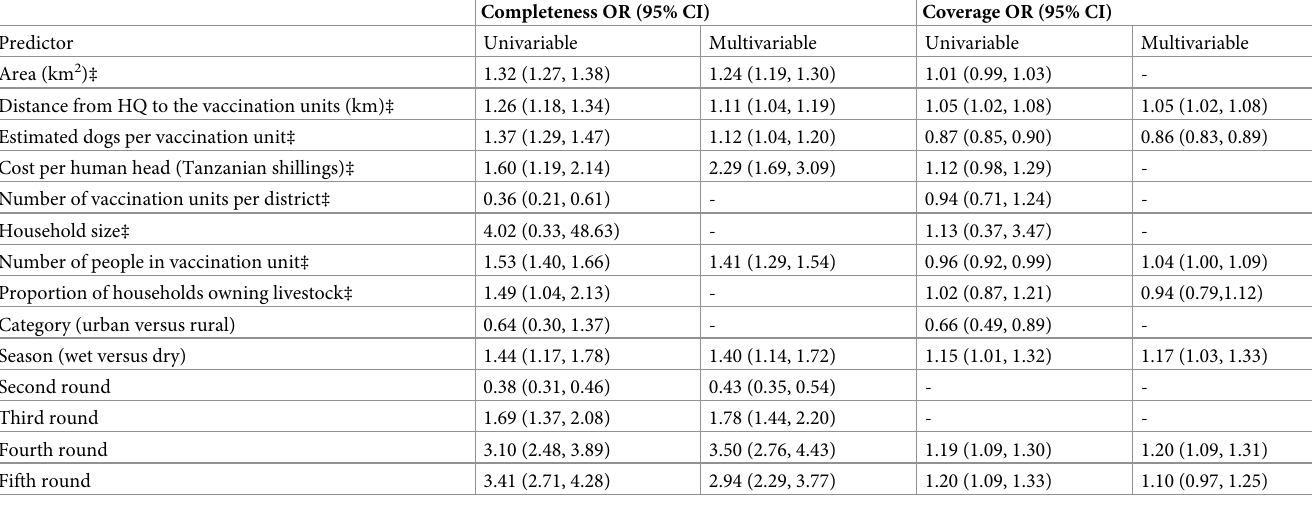
Table 4. Odds ratio (OR) estimates of characteristics of vaccination units (predictors) and the success of rabies vaccination campaigns in terms of coverage and completeness. OR and 95% confidence intervals (CIs) were estimated using binomial generalised linear mixed-effects models (GLMMs). Each predictor was fitted sepa- rately in univariable models, adjusted only for random effects and round, and combined in a mutually adjusted multivariable model. Non-significant predictors were removed from the model in a single round of model selection (see main text for